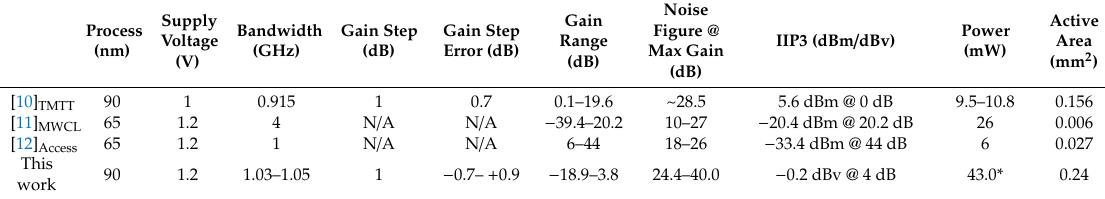
Table 2. Performance Summary and